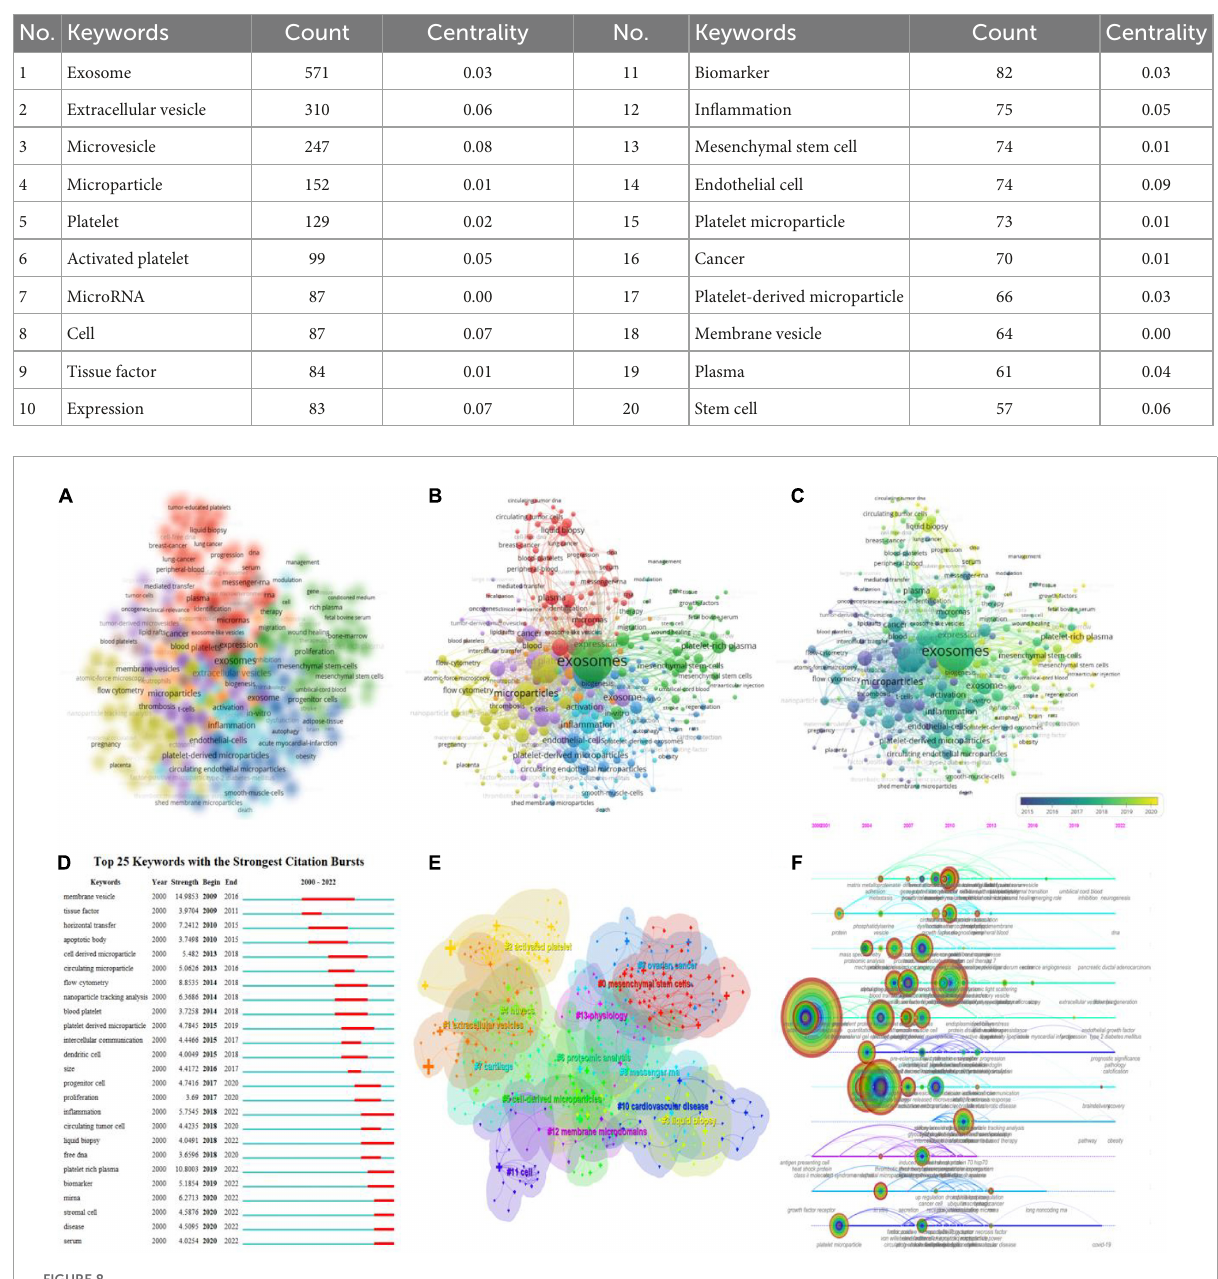
TABLE 7 The top 20 keywords for platelet